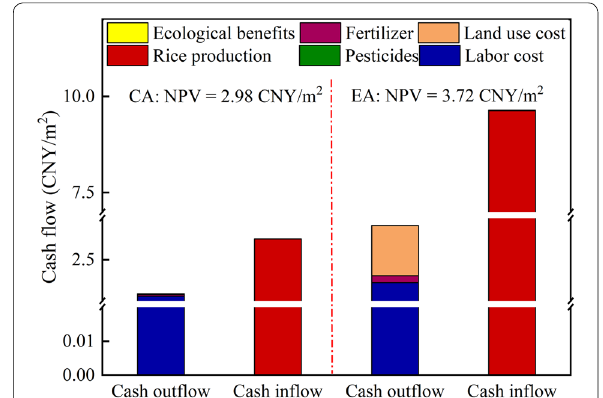
Fig. 6 Economic benefit assessment between CA and EA. CA conventional agriculture, EA ecological